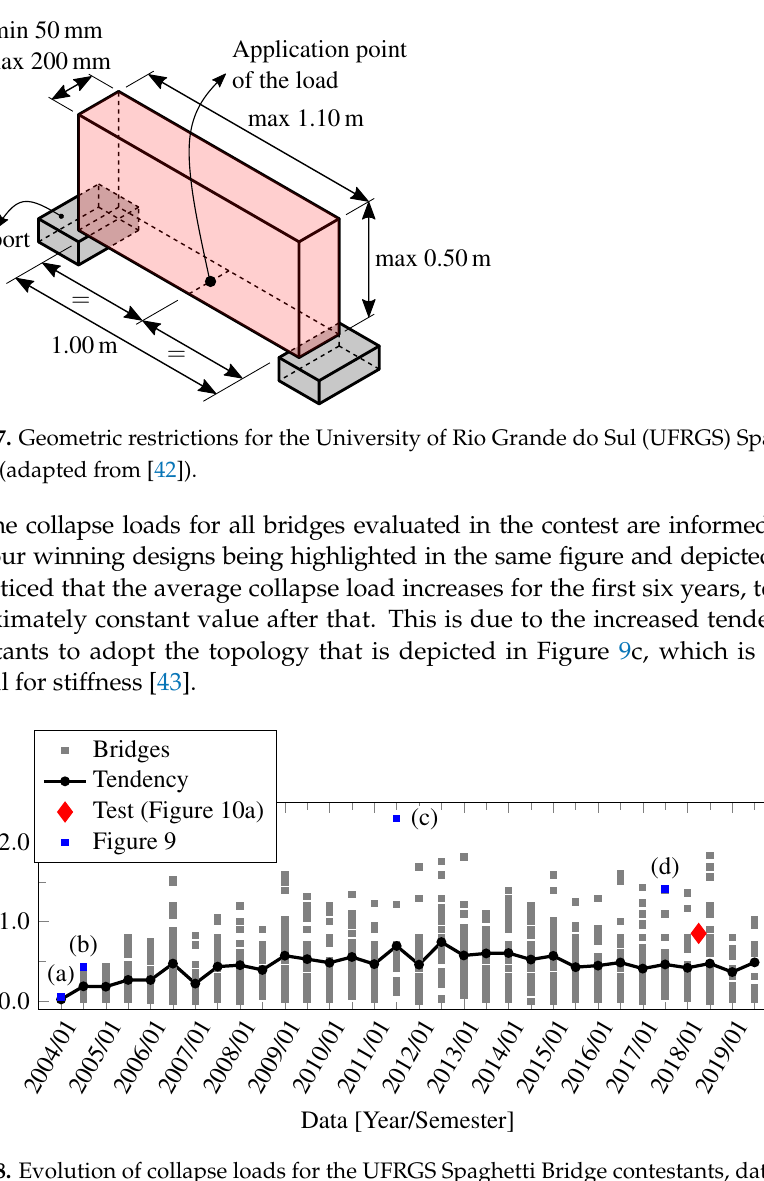
Figure 8. Evolution of collapse loads for the UFRGS Spaghetti Bridge contestants, data from